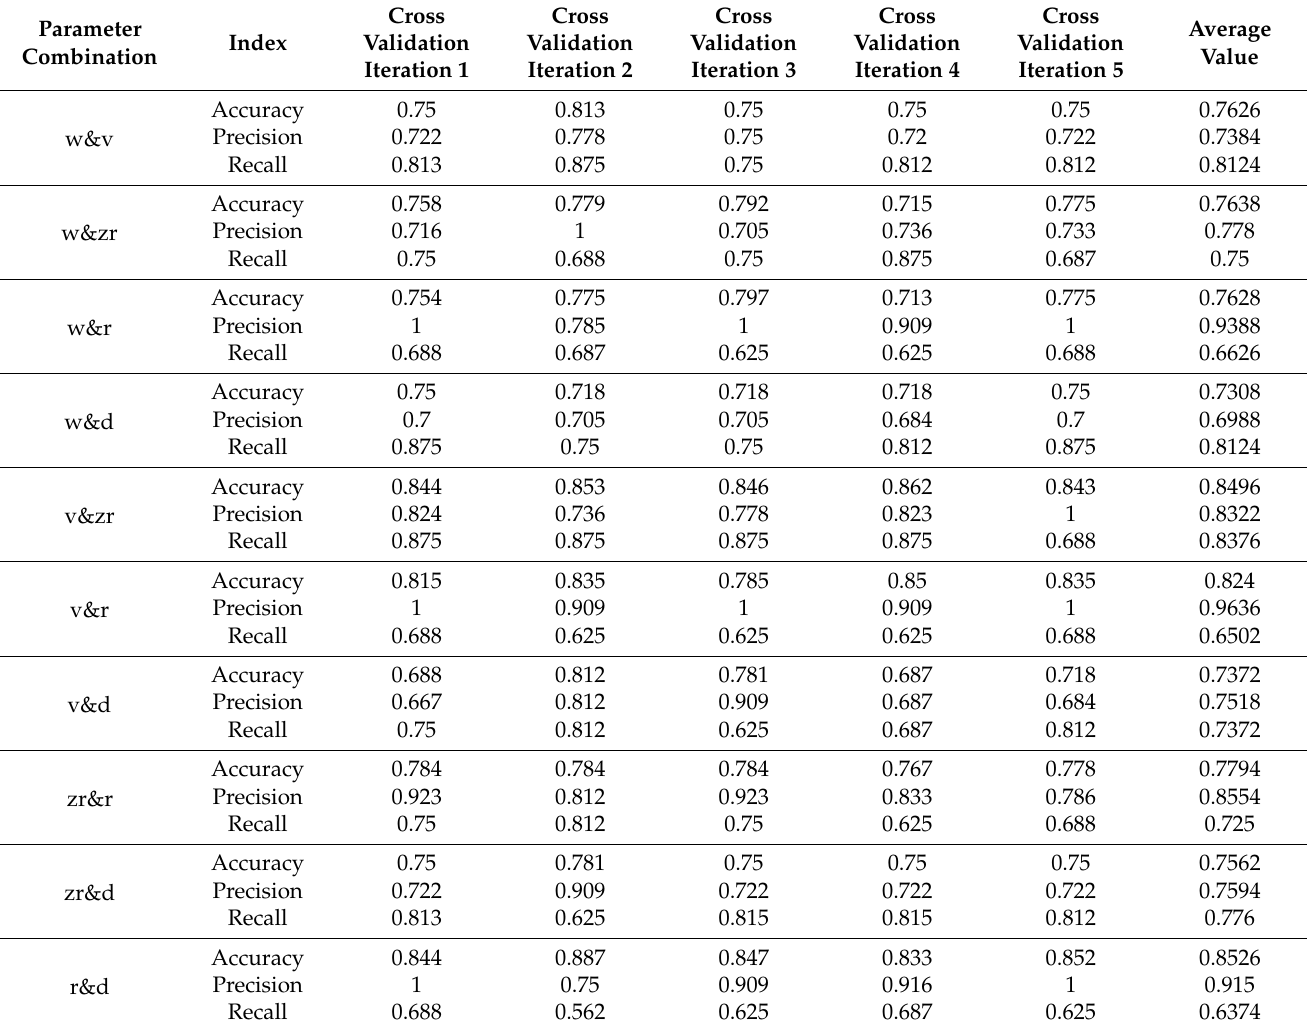
Table 7. Index of the classification of human fall and object drop with combined